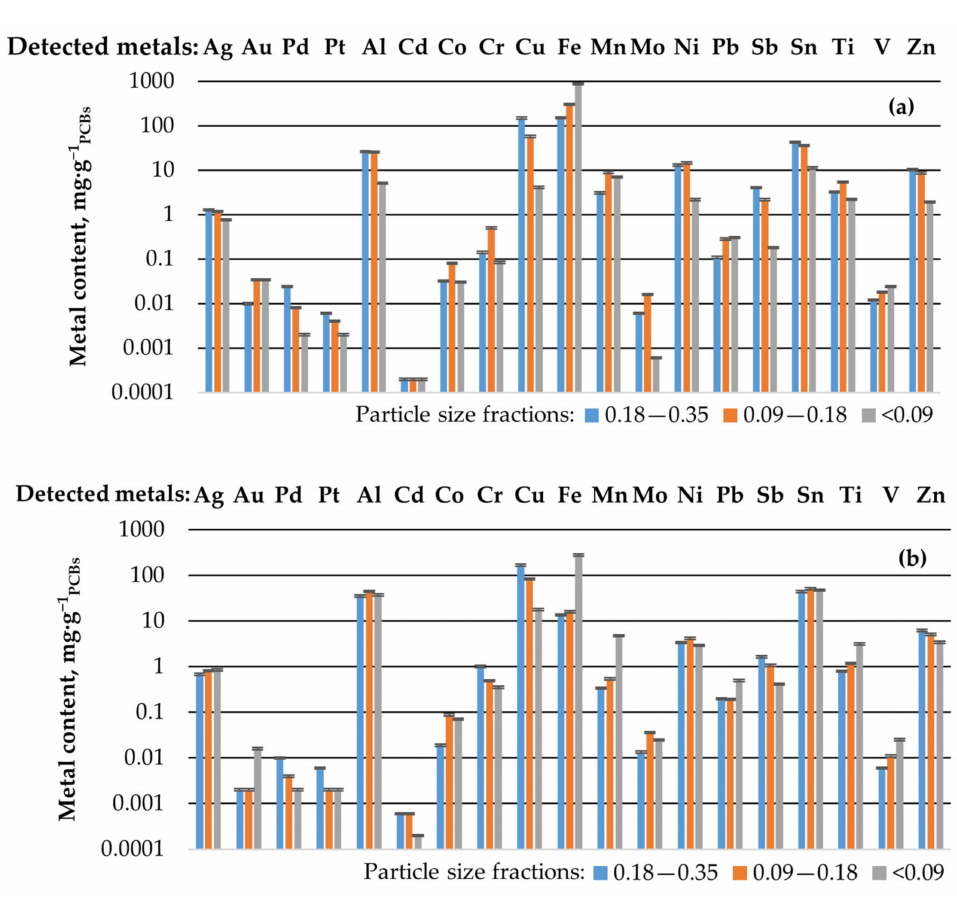
Figure 4. Dependence of element composition of milled fraction by particle size distribution for X1 (one-step) ( a ) and X1 (>2.8) + X2 (double-step for >2.5 mm fractions from first milling) ( b )